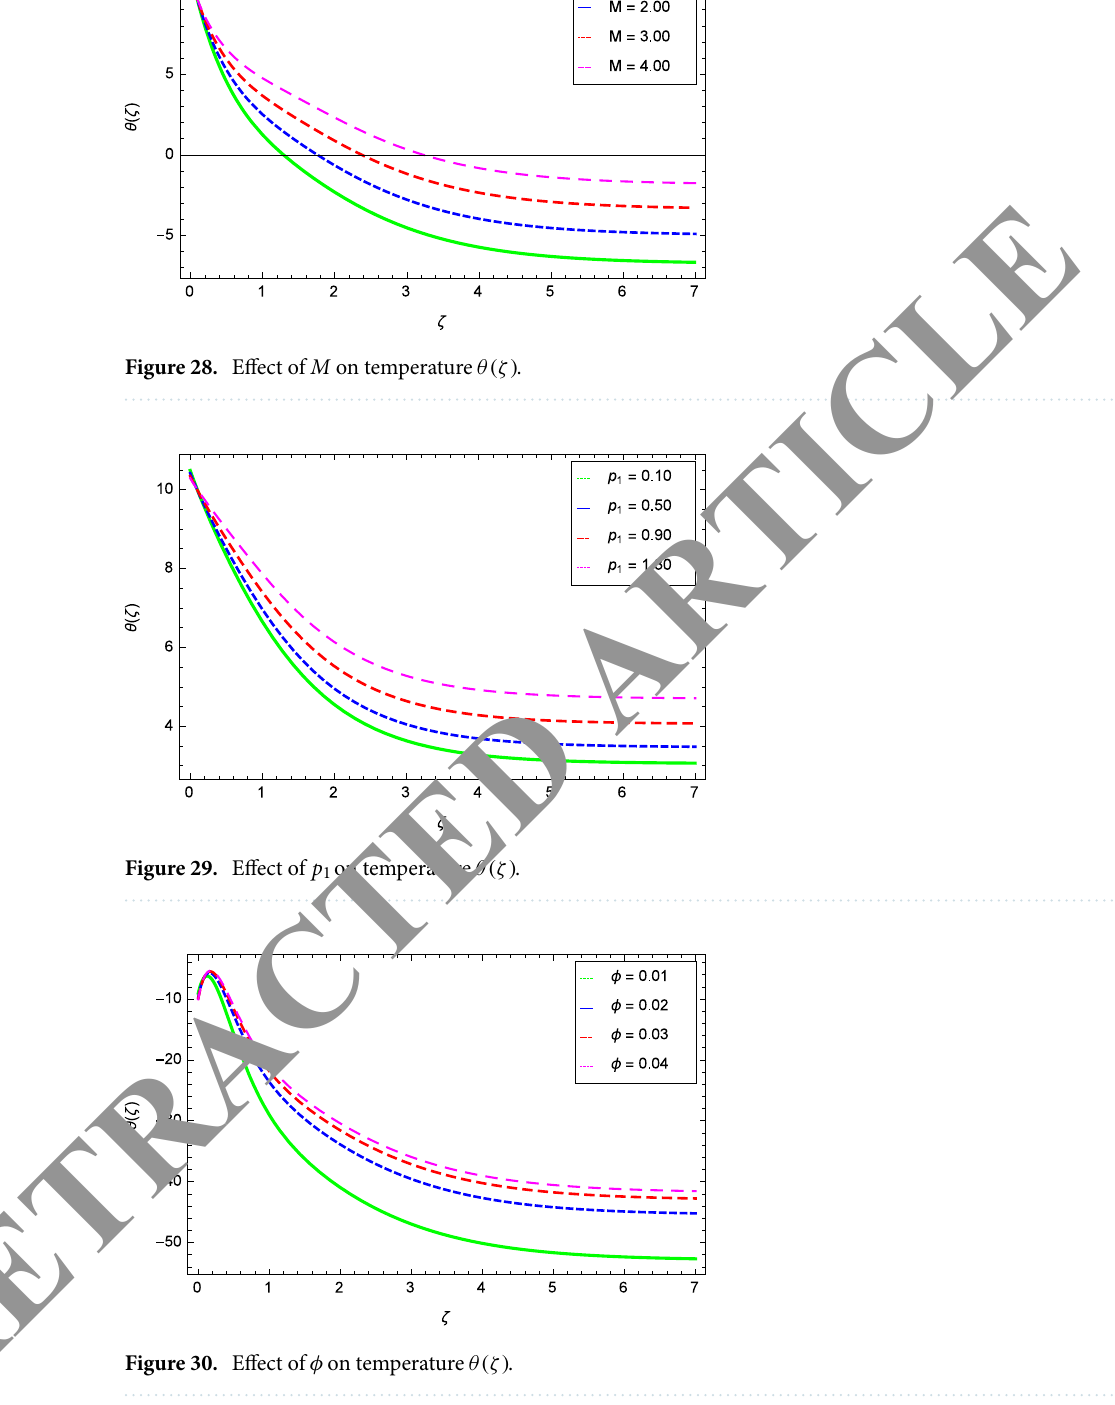
Figure 30. Effect of φ on temperature θ(ζ) .